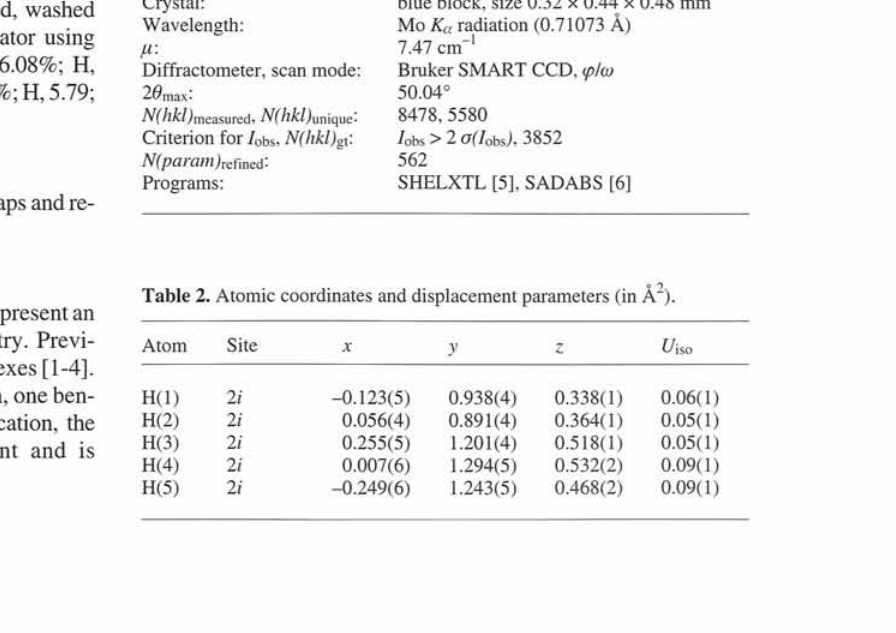
Table 1. Data collection and handling.